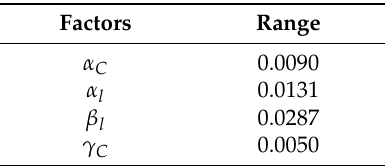
Table 7. Range analysis